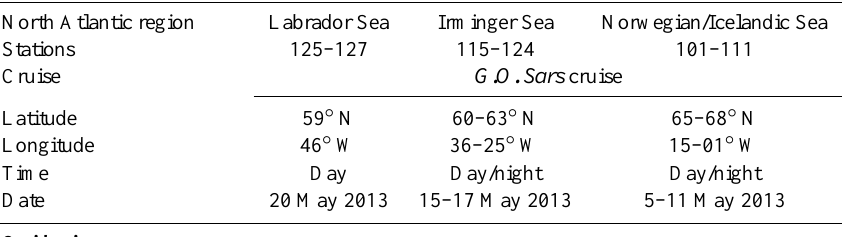
Table 7. G.O. Sars , Harstad and macroplankton data set. List of jellyfish taxa collected in the 0–1000m layer, in different North Atlantic regions. Data from Licandro et al.